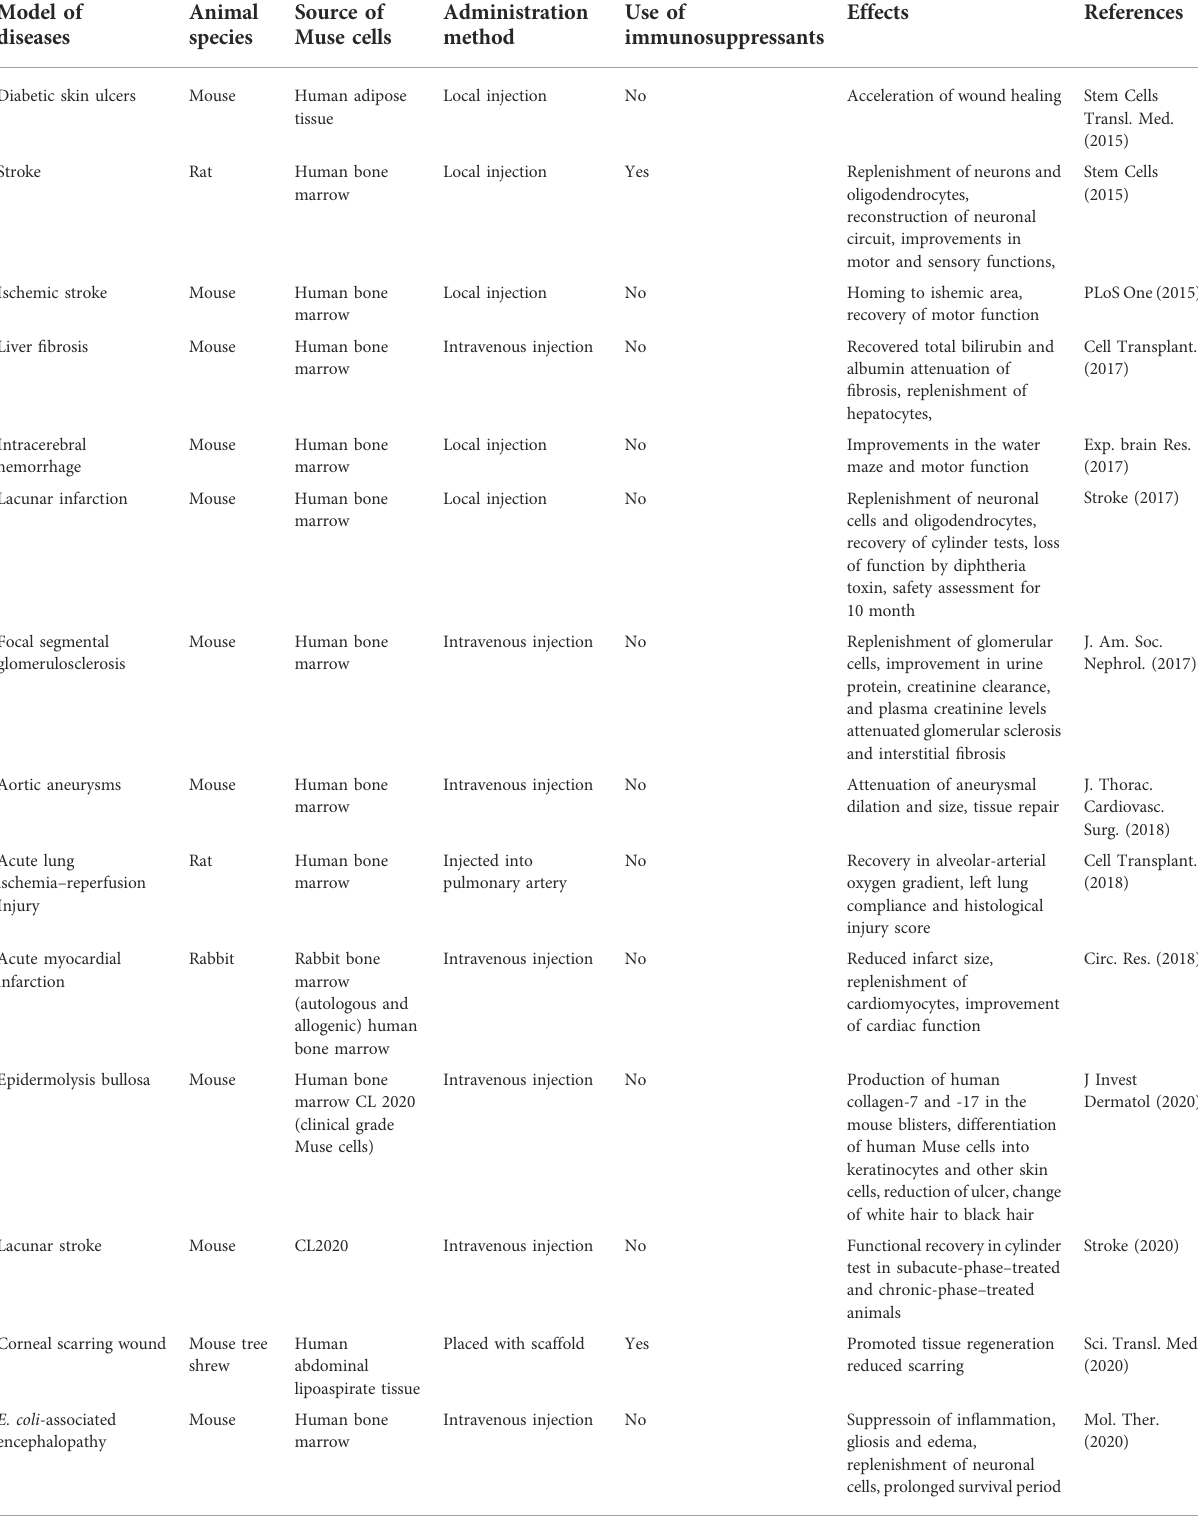
TABLE 2 Pre Clinical studies of muse